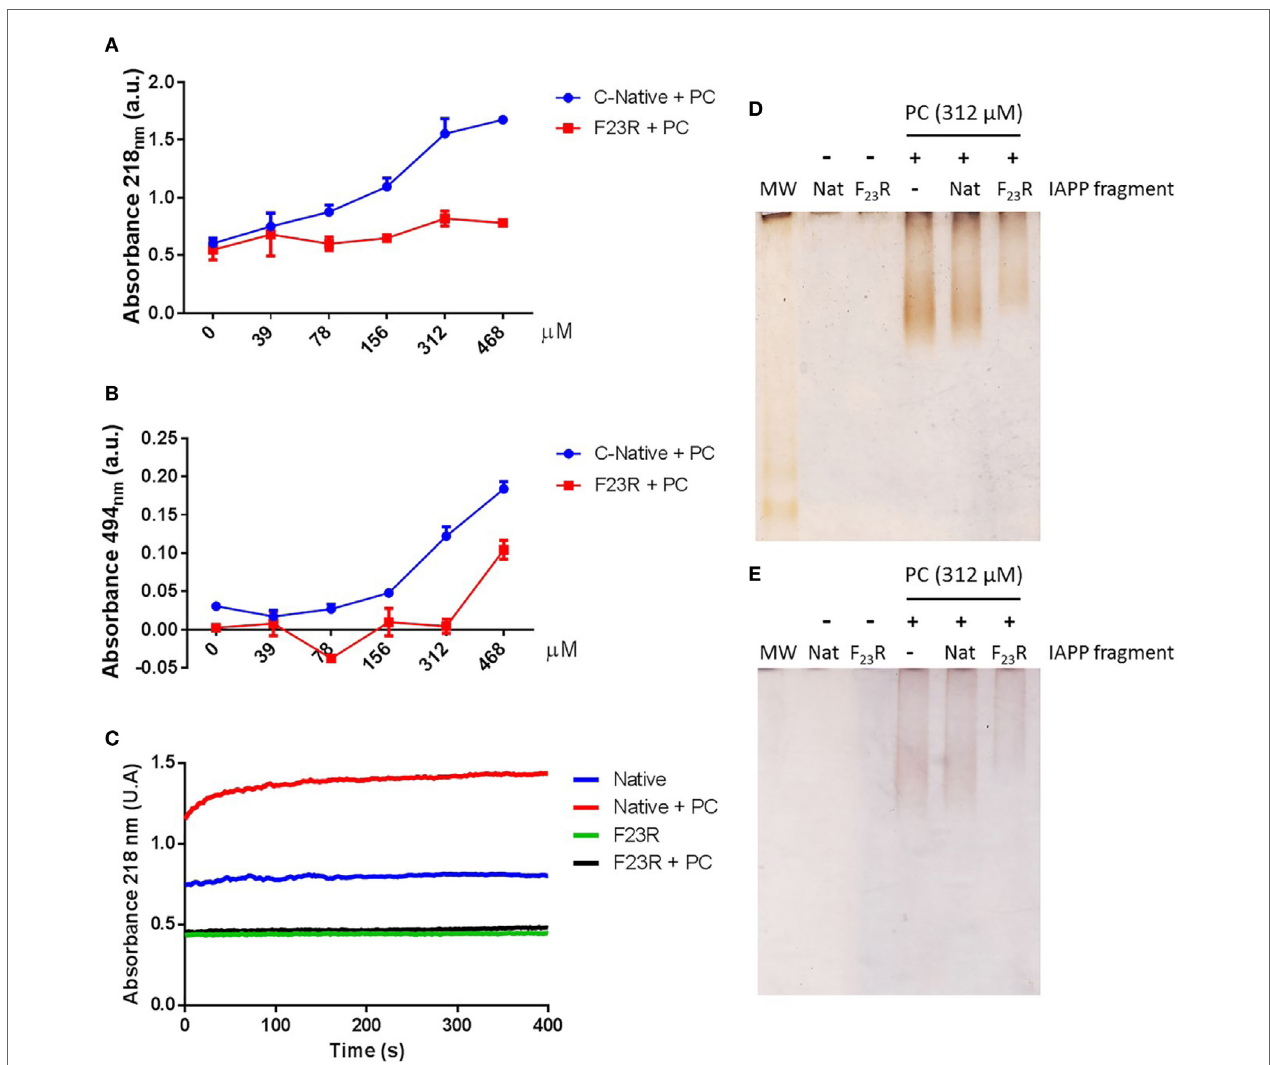
FigUre 5 | F 23 R inhibits conformational changes toward the formation of beta-structures in the C-terminal of islet amyloid polypeptide. (a) Evaluation of peptide- bond conformational changes in the native C-terminal and F 23 R in increasing phosphatidylcholine (PC) concentrations. (B) Under the same conditions, values of birefringence change by Congo-red assay. (c) Effect of treatment with PC on the kinetics of aggregation. Characterization of lipid/peptide interactions by native polyacrylamide gradient gels (1–15%) and processed by silver (D) and Sudan black (e)